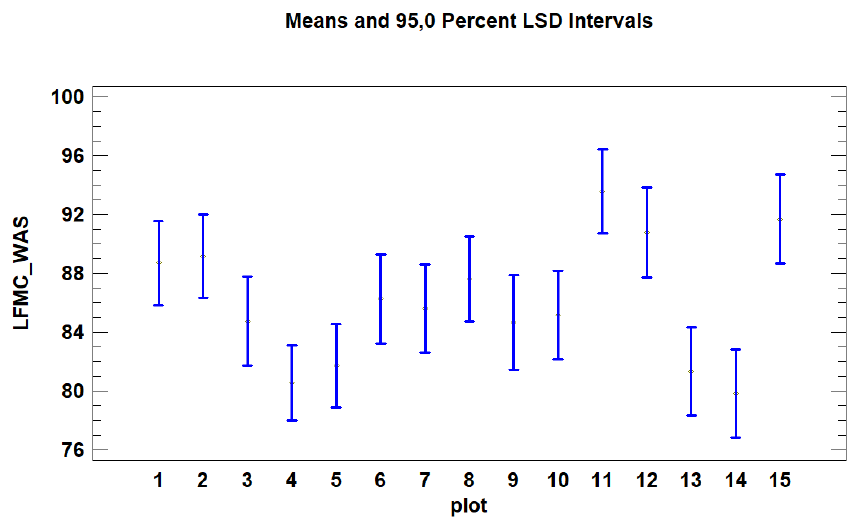
Figure 4. Comparison between LFMC_WAS (LFMC weighted average in shrubs) and LFMC_WAV (LFMC weighted av- erage in all vegetation species).